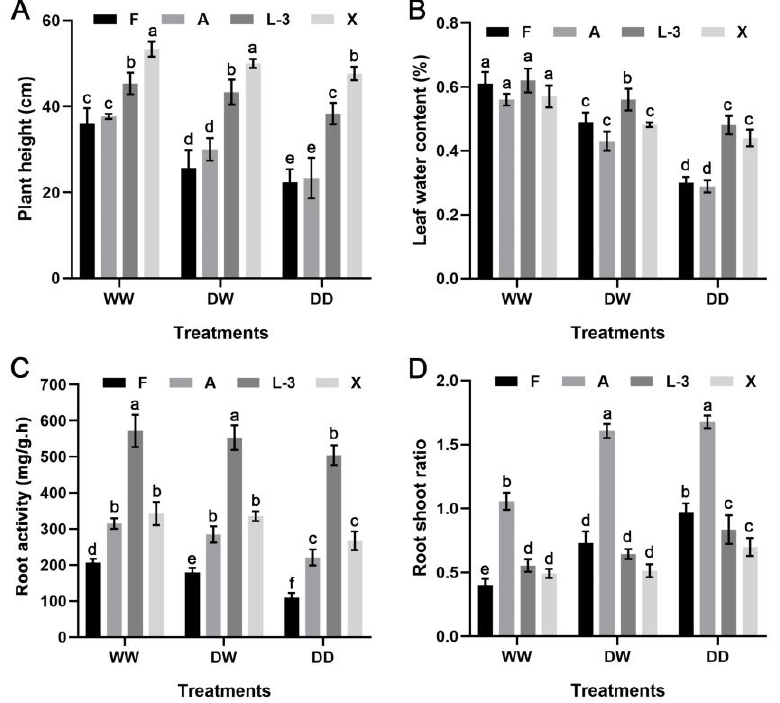
Figure 8. Determination of stress-related growth indexes under different conditions. ( A ), the plant height. ( B ), the leaf water content. ( C ), the root activity. ( D ), the root shoot ration. WW, irrigation condition. DW, half-irrigation condition. DD, drought condition. F, Favorita cultivar. L-3, Longshu No.3 cultivar. A, Atlantic cultivar. X, Xindaping cultivar. Each value is the average of three repli- cates, and error bars represent ± SD. Different letters (a-e) represent significant differences at p < 0.05 level.